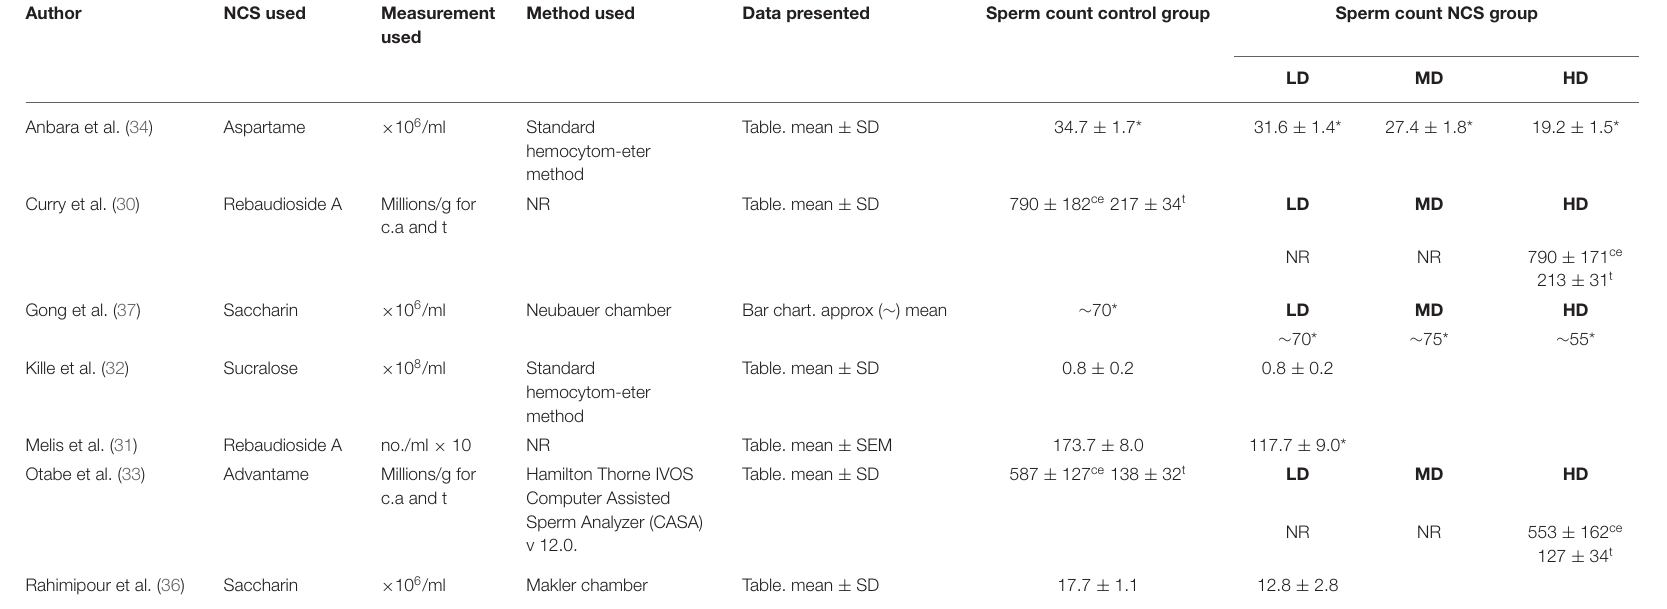
TABLE 3 | Data of included studies reporting sperm count outcomes in NCS